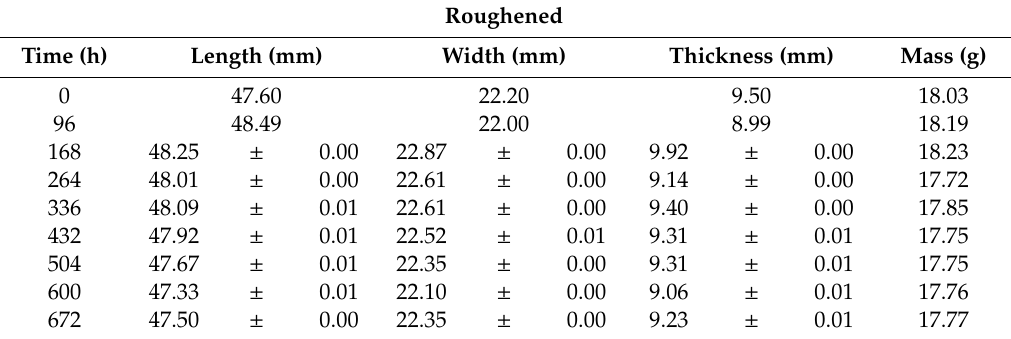
Table 3. Roughened sample dimension and mass change measurements.